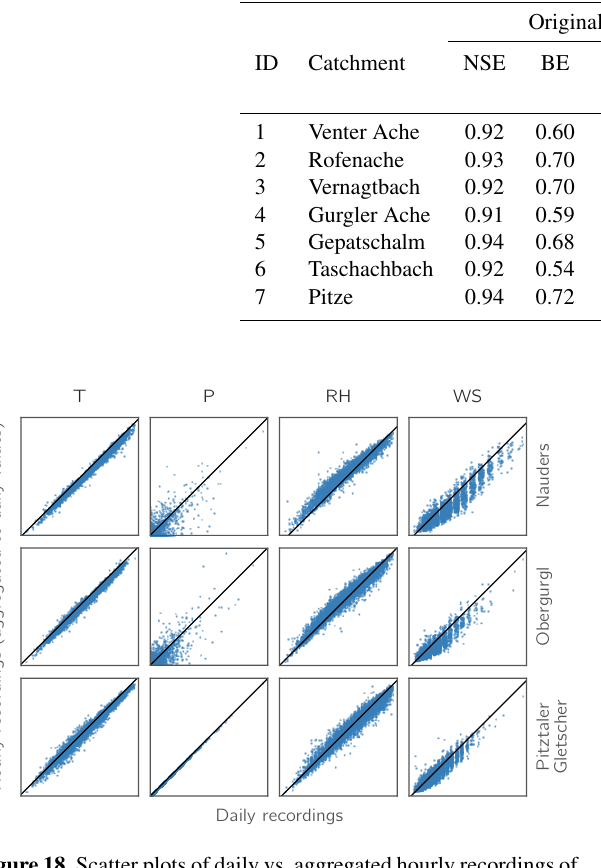
Figure 18. Scatter plots of daily vs. aggregated hourly recordings of air temperature ( T ), precipitation ( P ), relative humidity (RH), and wind speed (WS) for three stations in the study